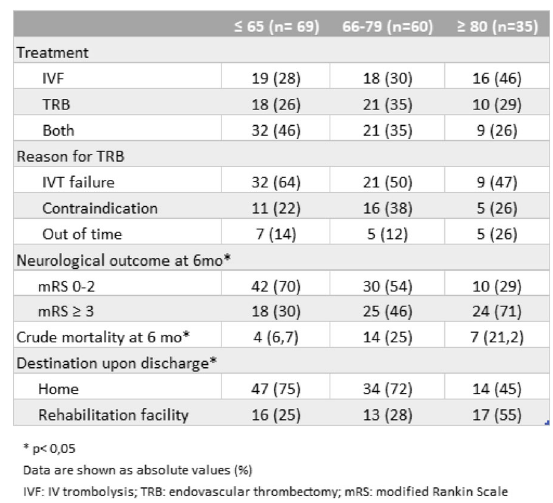
Table 2 (abstract 0360). See text for